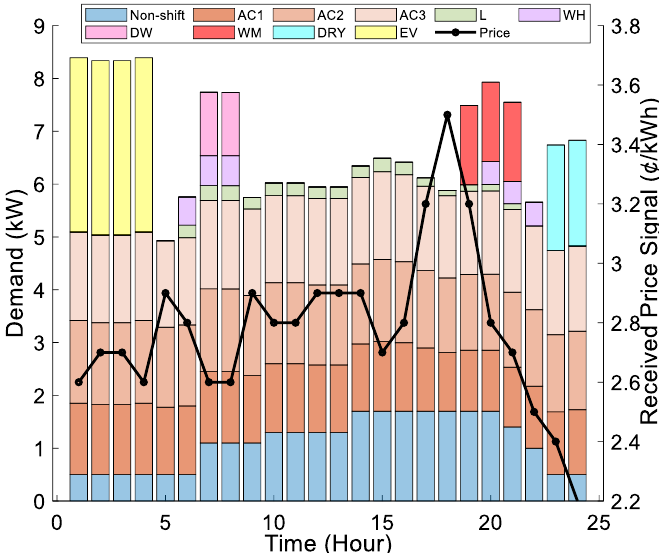
Figure 5. Load profile considering the impact of transformer loss-of-life cost.